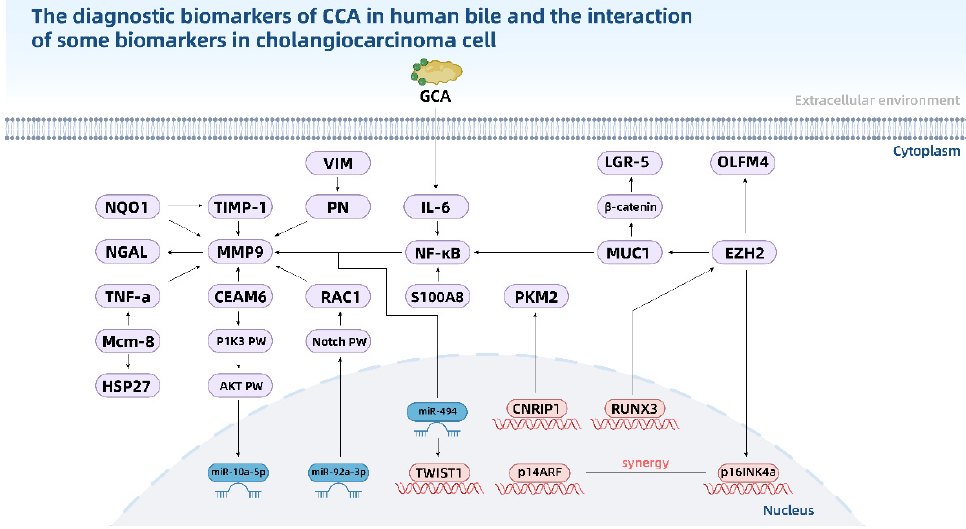
Figure 2. The diagnostic biomarkers of CCA in human bile and the interaction of some biomarkers in cholangiocarcinoma cell. “PW” means pathway.